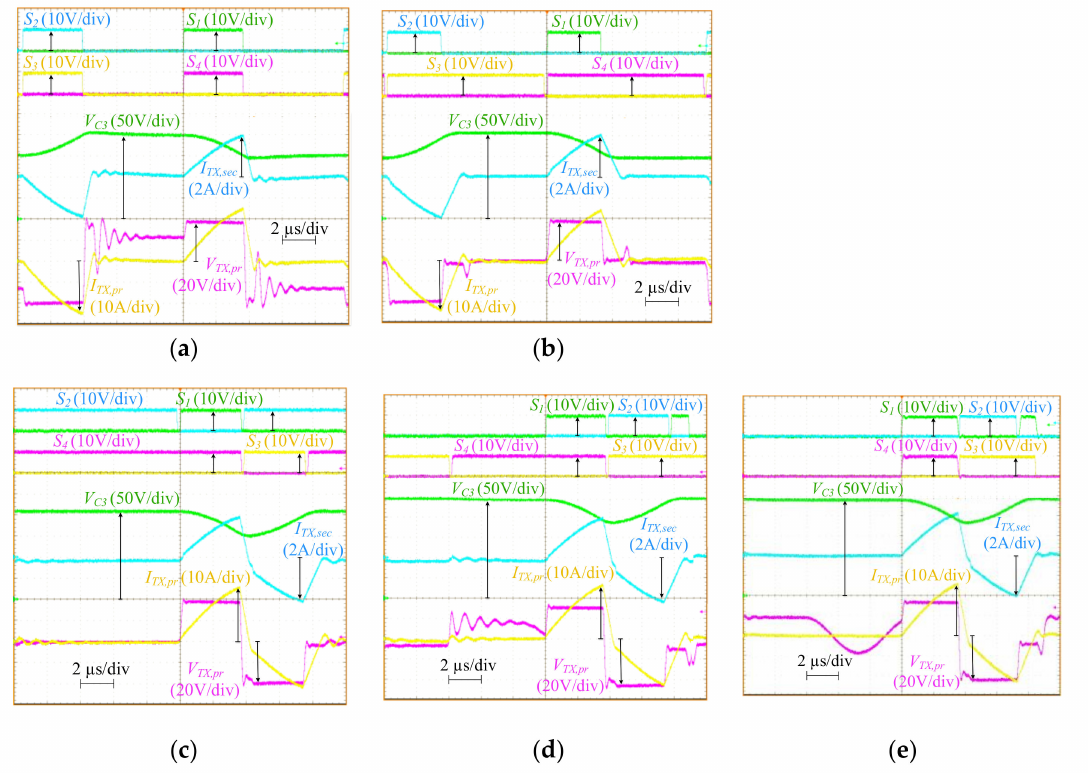
Figure 8. Experimental steady-state waveforms of the SRC operating at V in = 40 V, P = 200 W for PWM ( a ), HPWM ( b ), SPWM ( c ), HSPWM ( d ), and ISPWM ( e )